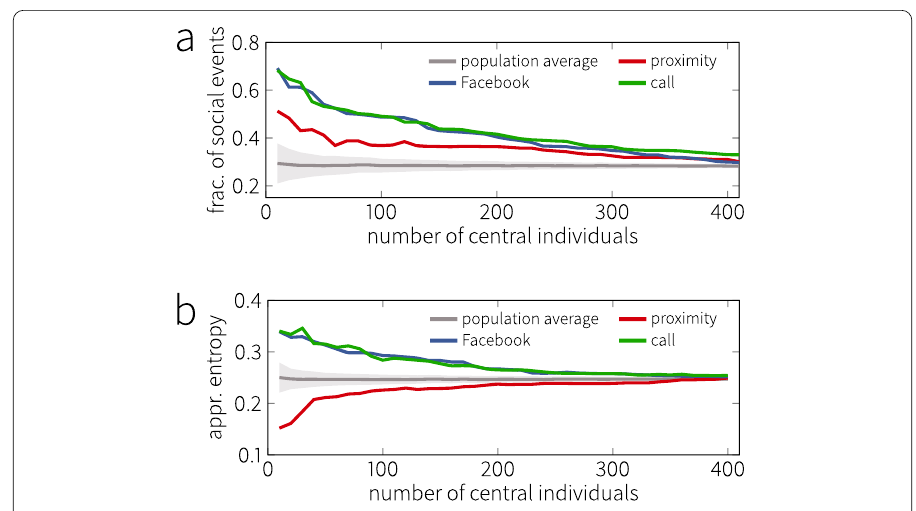
Figure 8 Activity during social hours and regularity when closeness centrality is used to select central individuals in the communication networks. (a) Median number of physical contact during social hours. (b) Approximate entropy of the contact activity. Grey line denotes the population median with error bands representing lower and upper quartiles. All data is calculated over a four month period between February and May